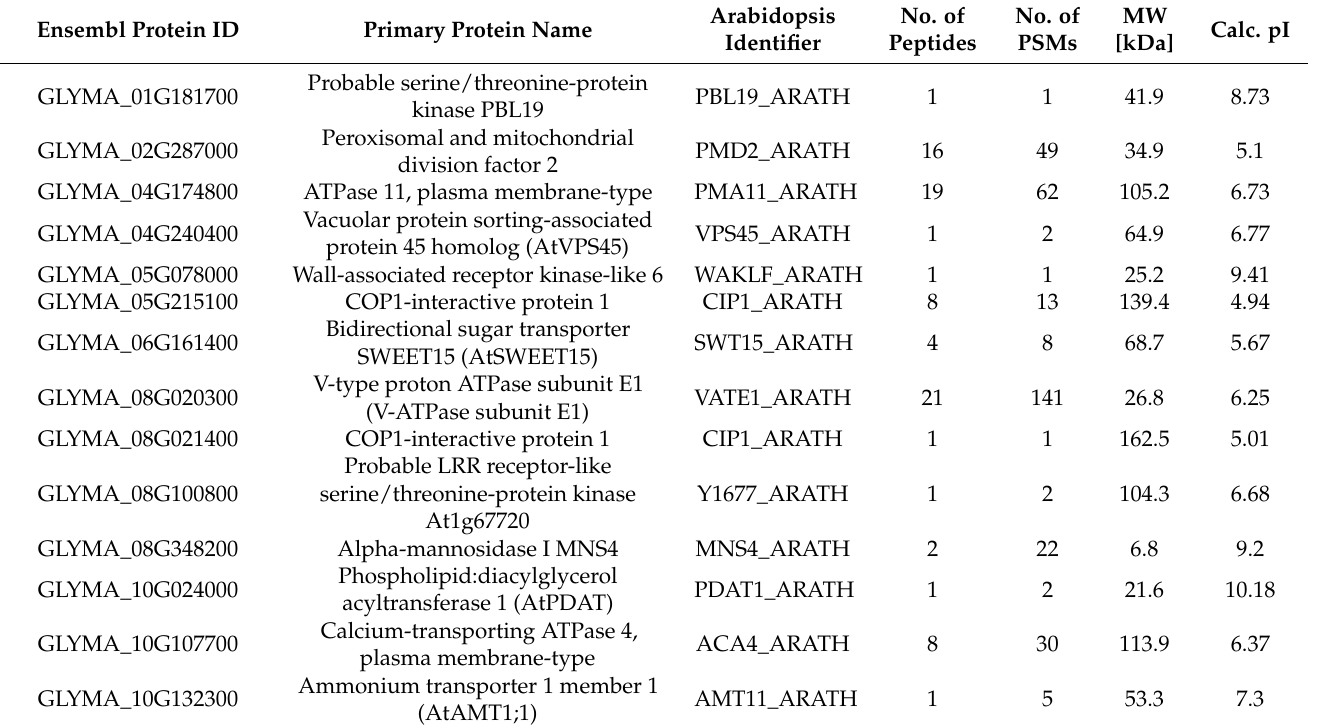
Figure 6. Up- and down-regulated membrane proteins in roots identified using label-free quantification, with a − log 10 p -value > 0.05 and |fold change| value > 0.5. Red dots represent up-regulated proteins and blue dots represent down-regulated proteins. Gray dots represent membrane proteins with unchanged expressions. Table 3. Up-regulated membrane proteins under salt stress in soybean roots.